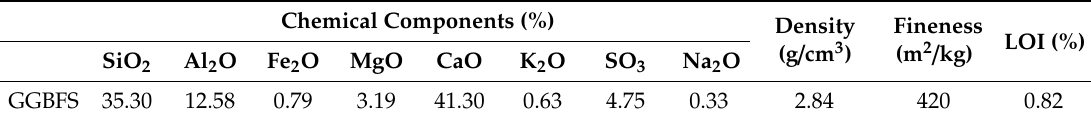
Table 1. Chemical and physical properties of